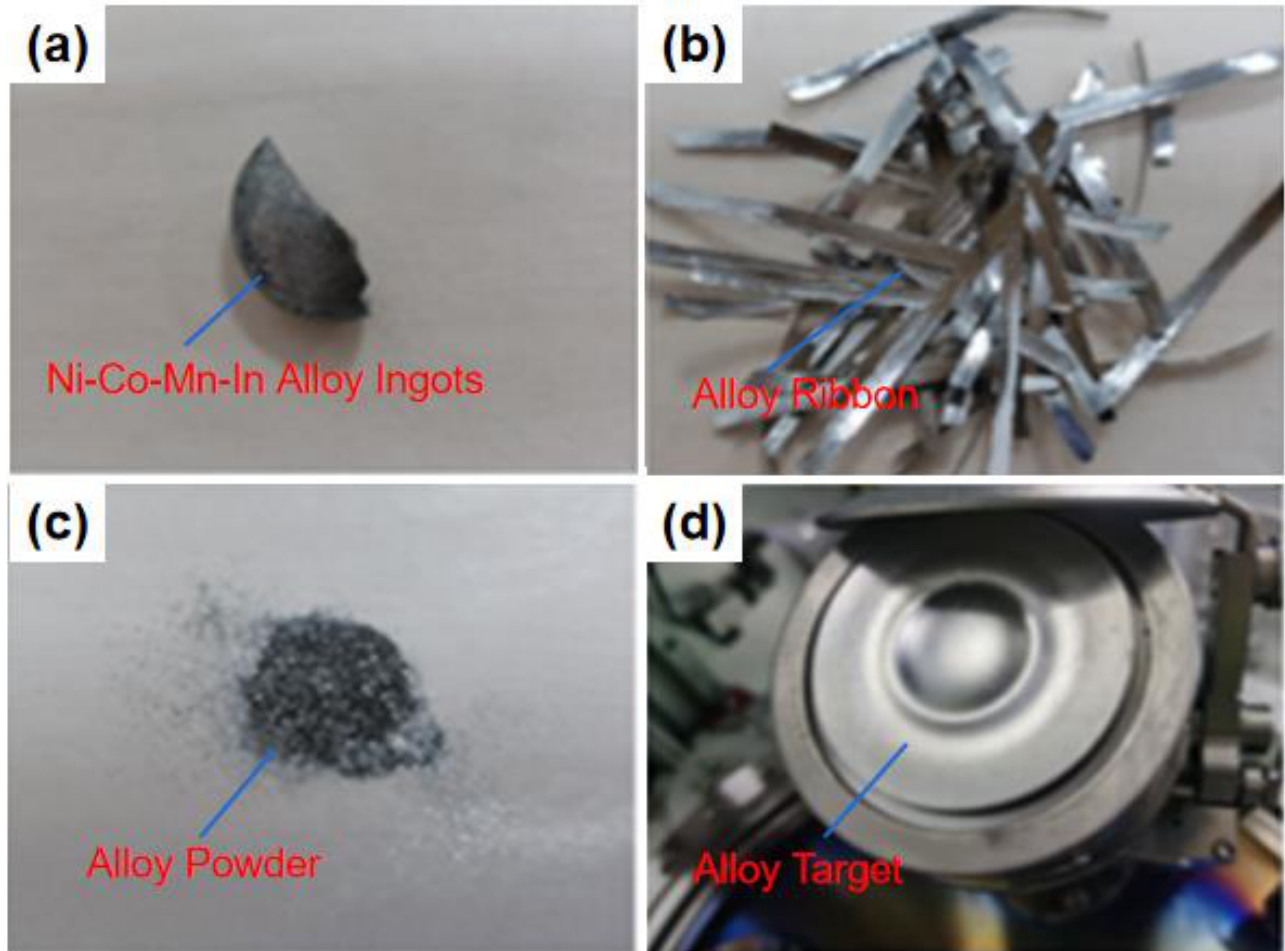
Figure 1. The preparation process of the Ni-Co-Mn-In magnetic phase transition alloy target material. ( a ) The Ni-Co-Mn-In alloy ingots by arc melting. ( b ) The Ni-Co-Mn-In alloy thin ribbon by melt spinning. ( c ) The Ni-Co-Mn-In alloy thin ribbon grind to the alloy powder. ( d ) The hot briquetting Ni-Co-Mn-In alloy target material by high temperature and pressure.